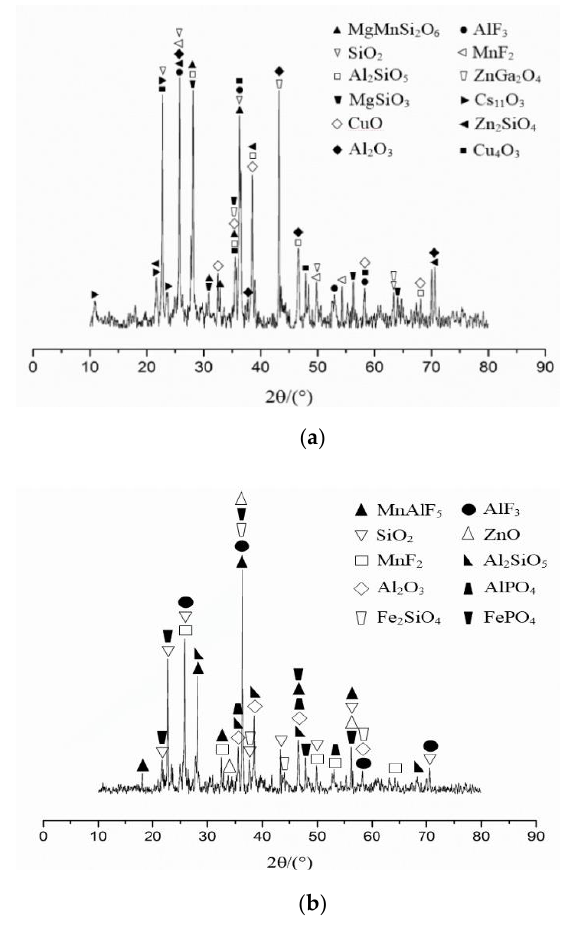
Figure 6. XRD analysis results of flux residua: ( a ) 6061 aluminum alloy; ( b ) Q235 low-carbon steel.